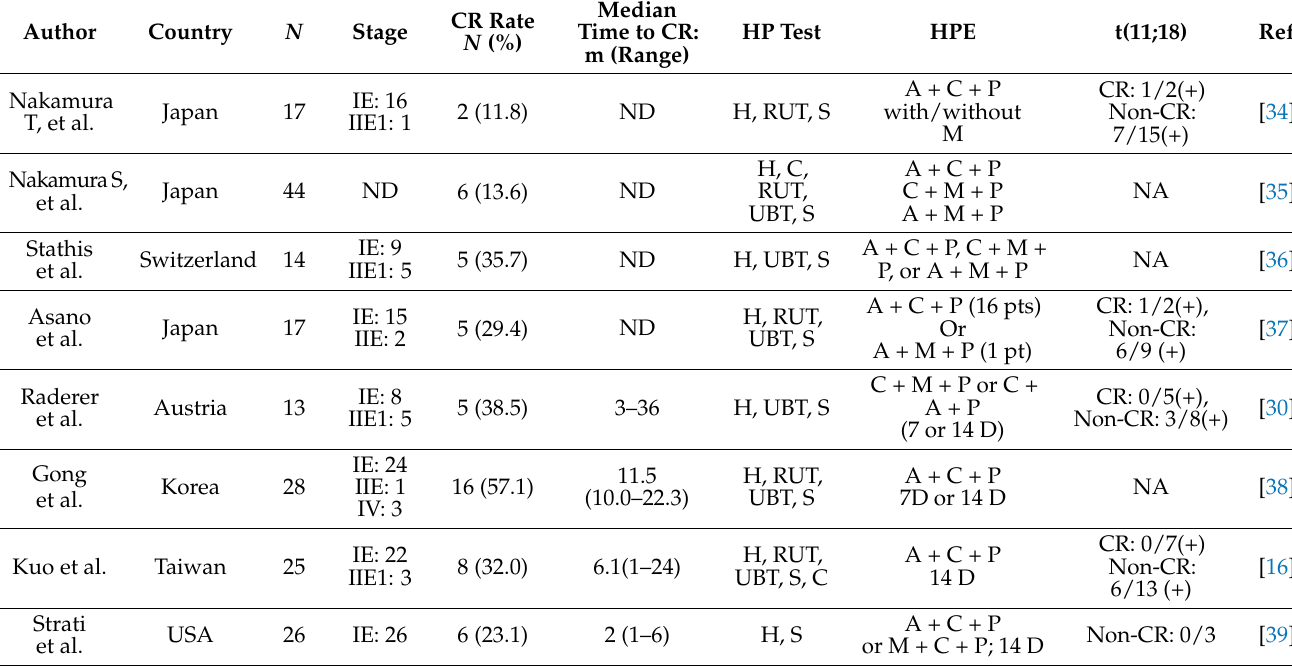
Table 1. Published reports (more than 13 patients) on the efficacies of first-line antibiotics treatment in HP-negative gastric MALT